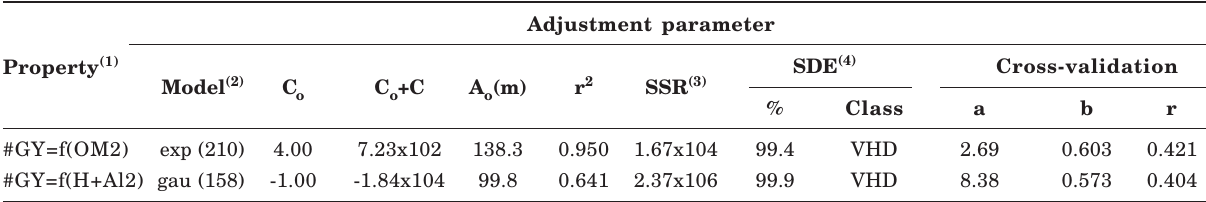
Table 6. Parameters of cross-semivariograms of rice grain yield and some chemical properties of a Typic Acrustox under no-tillage